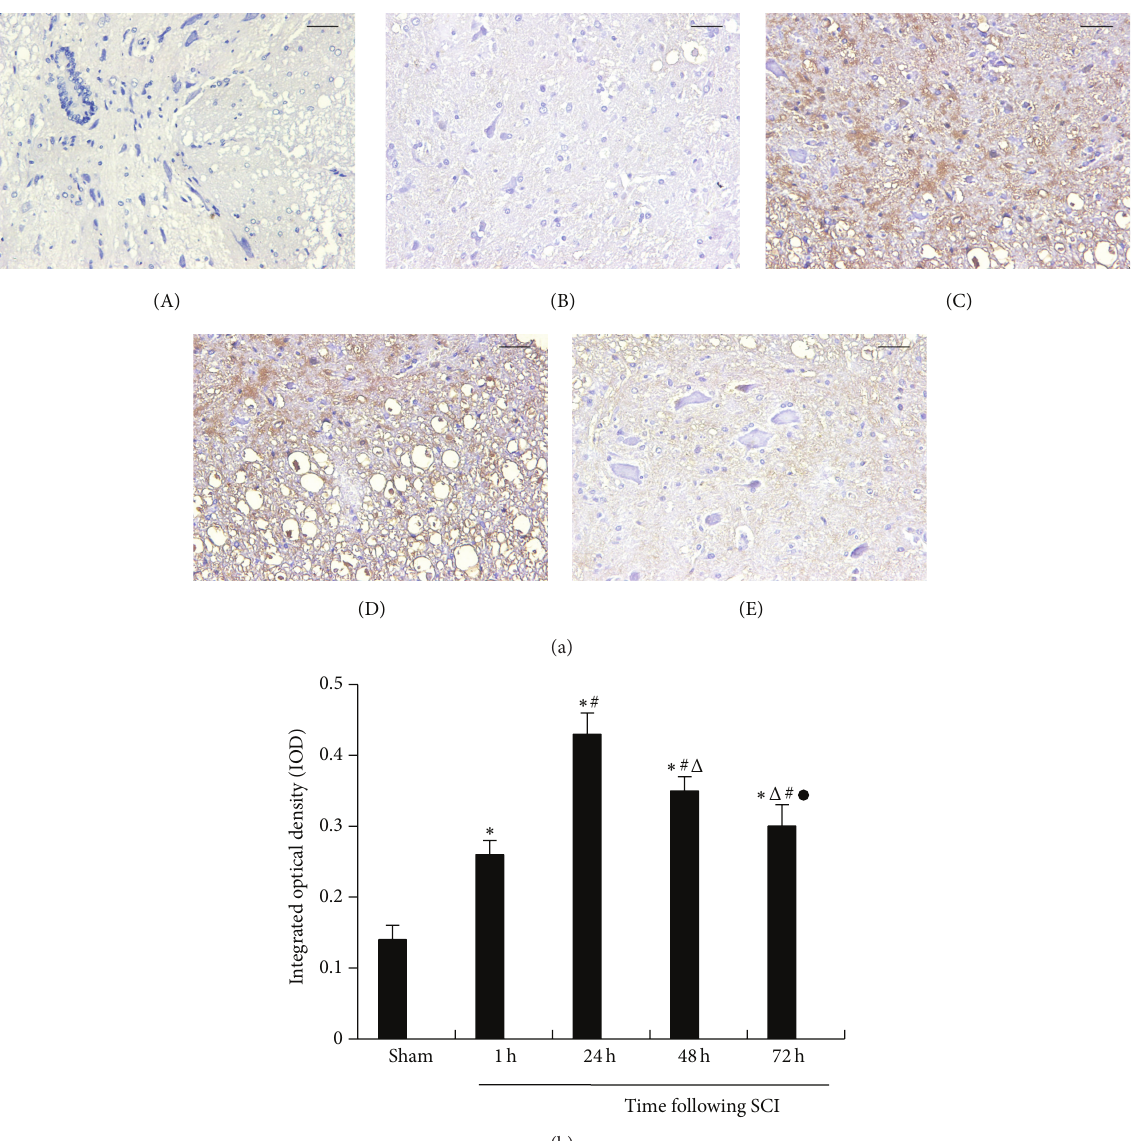
Figure 3: (a) Representative p-STAT3 Immunohistochemical images in spinal cord tissue (brown granules, original magnification × 400). The sham-operated group (A) and SCI groups at 1h (B), 24 h (C), 48 h (D), and 72 h (E). The digitized image shows labeled p-STAT3 immunohistochemistry on tissue. The IOD of p-STAT3 immunohistochemistry was assessed. The rat SCI model group showed significantly increased p-STAT3 expression and peaked at 24 h. Bar equals 50 𝜇 m. (b) Morphometric quantitate of p-STAT3 protein expression in spinal cord tissues. The IOD in different groups was 0.14 ± 0.02 , 0.26 ± 0.02 , 0.43 ± 0.03 , 0.35 ± 0.02 , and 0.30 ± 0.03 , respectively. Representative spinal cord tissue sections from the sham-operated group ( 𝑛 = 15 ) and SCI groups at 1h ( 𝑛 = 15 ), 24 h ( 𝑛 = 15 ), 48 h ( 𝑛 = 15 ), and 72 h ( 𝑛 = 15 ) rats. The data are presented as the mean ± the SE. ∗ 𝑃 < 0.05 versus sham, # 𝑃 < 0.05 versus 1 h, △ 𝑃 < 0.05 versus 24 h, and e 𝑃 < 0.05 versus 48